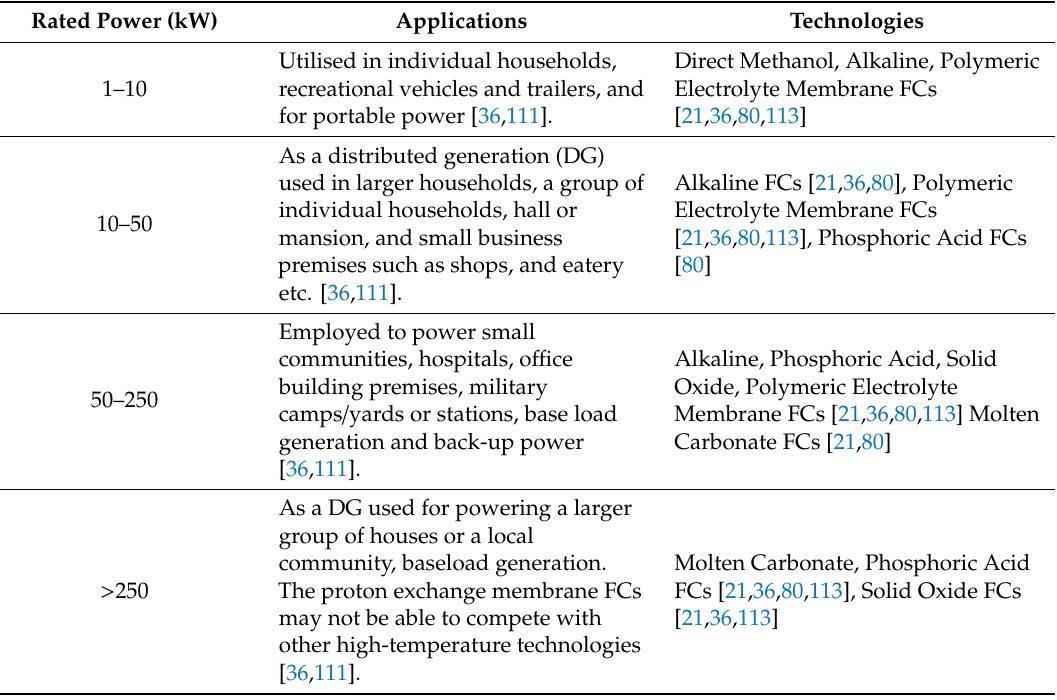
Table 5. Applications of FC systems based on rated power